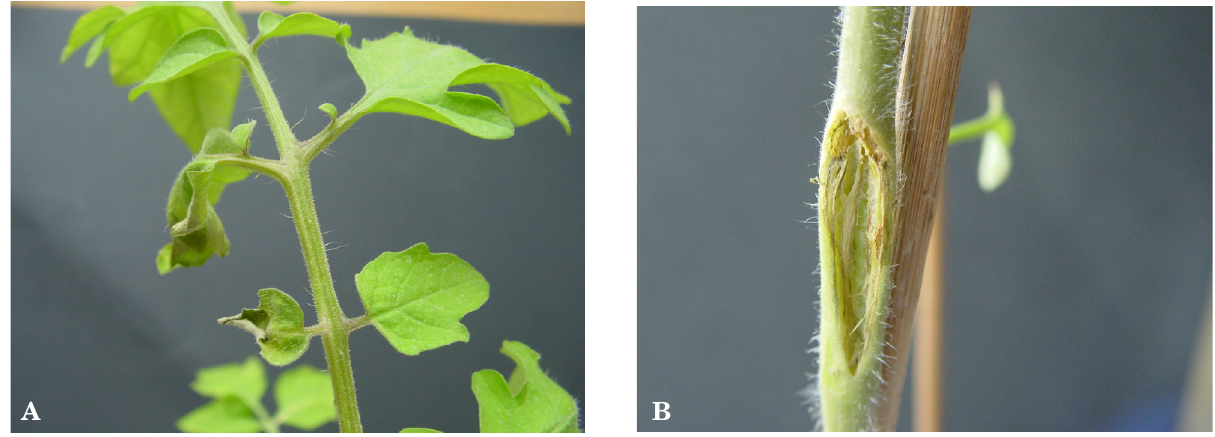
Figure 3. Symptoms seen after inoculation. A. Unilateral wilt of leaflets. B. Canker on tomato